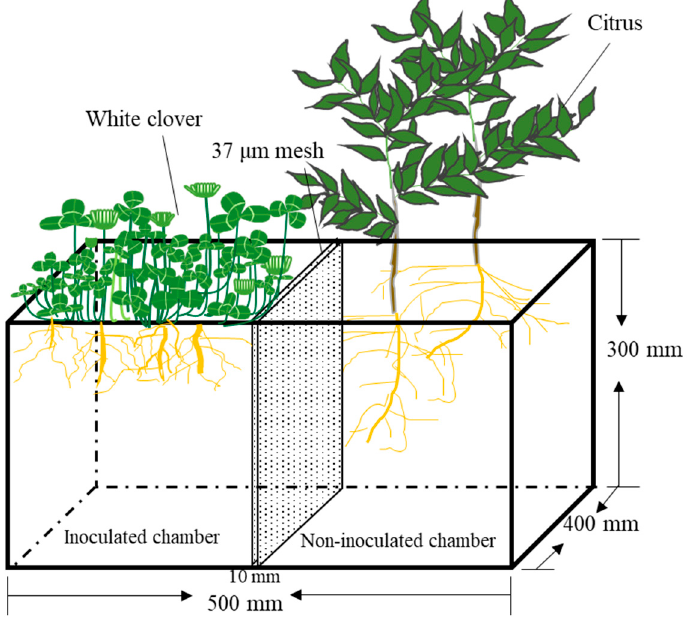
Figure 1. Schematic view of a three-column chamber pot. One chamber held 50 white clover seedlings that were inoculated with or without rhizobium and/or mycorrhizal fungus, and the other chamber was for two non-inoculated citrus seedlings.